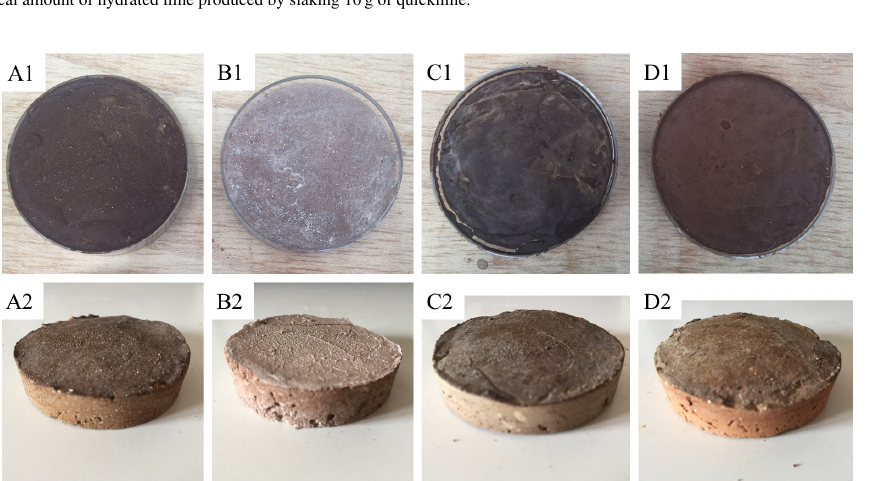
Figure 1. Appearance of prepared model